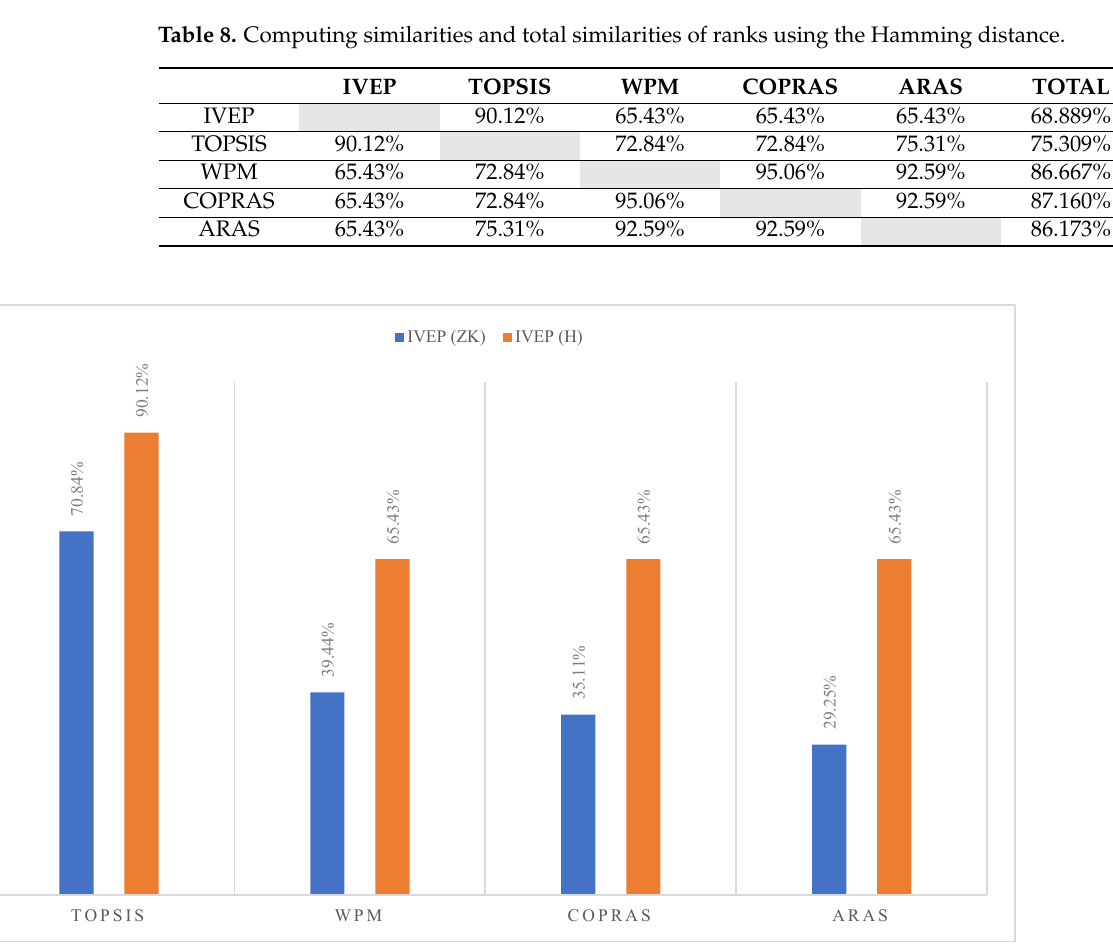
Figure 7. The comparison between similarities of IVPEP’s outputs with other algorithms’ outputs, generated by the Zakeri–Konstantas performance correlation coefficient (ZK) and the Hamming distance (HD).